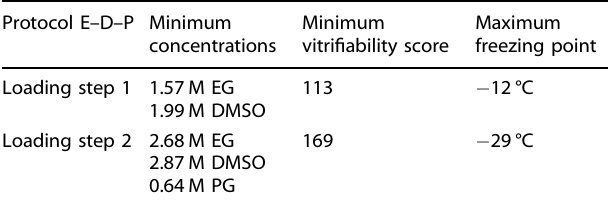
Table 2. Minimum cryoprotectant concentrations and vitri fi ability scores and maximum freezing point calculated at the end of each loading step in Protocol E – D (located at the center of the cartilage cube where x = 0